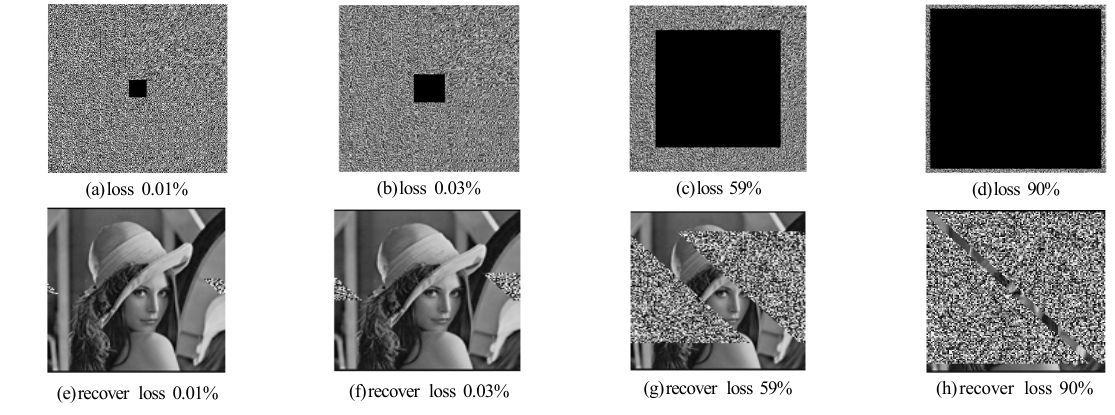
Figure 9. Data loss and recovery in different degrees.